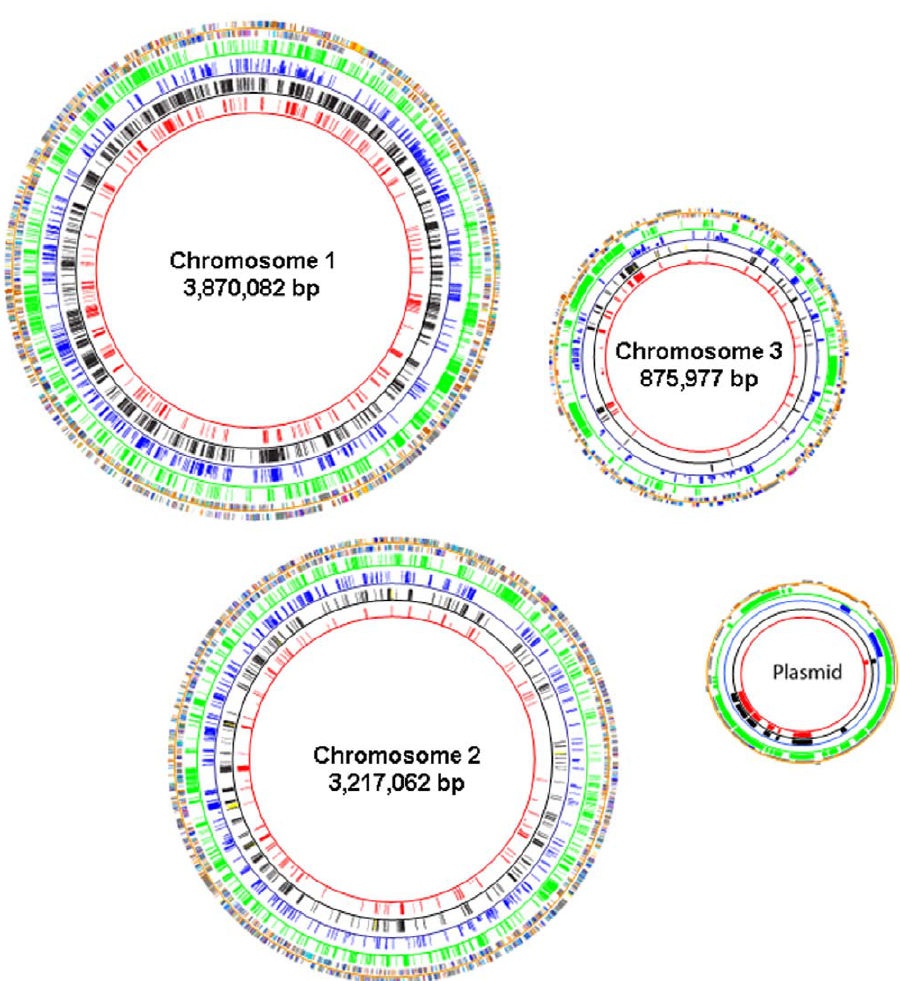
Figure 3. Chromosomal location of induced genes depicted for the three chromosomes and the megaplasmid of J2315. The outermost ring indicates the coding regions colored according to COG functional category. The rings denote (inwards): i) all predicted open reading frames in B. dolosa colored by their COG classification (Table S7), ii) the genes induced in J2315 in the comparison with HI2424 under CF conditions (green), iii) the J2315 homologs of the HI2424 genes induced under CF conditions, iv) genes induced in J2315 under CF conditions compared to SE conditions (black), v) the chromosomal location of genes induced in J2315 under CF conditions in both microarray comparisons (red). Genes induced under conditions are further described and classified in Supplementary Tables S1, S2, S3,